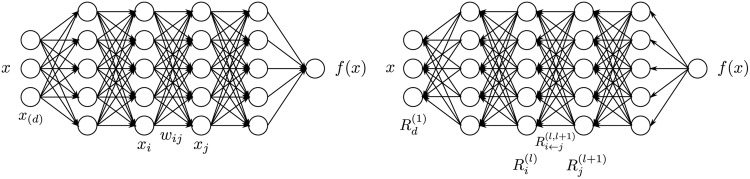
Multilayer neural network annotated with the different variables and indices describing neurons and weight connections.Left: forward pass. Right: backward pass.